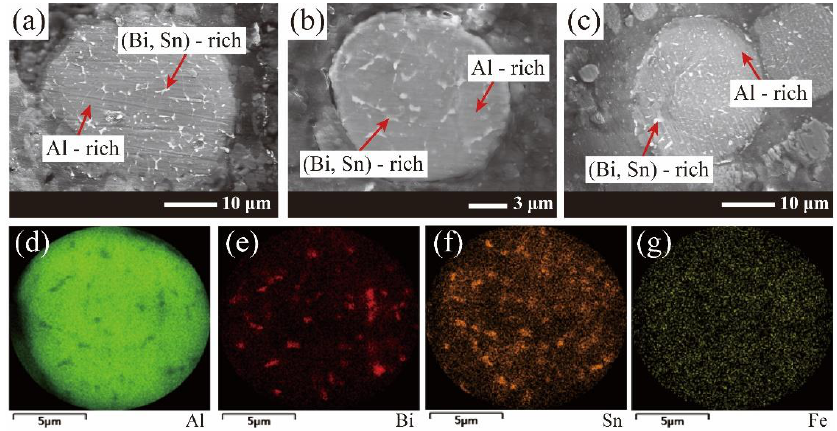
Figure 4. ( a – c ) SEM images of the cross-section morphology of Al-10Bi-7Sn-xFe (x = 0, 0.5, 1.5, 3) (wt.%) powders: ( a ) Al-10Bi-7Sn-0.5Fe (wt.%), ( b ) Al-10Bi-7Sn-1.5Fe (wt.%), ( c ) Al-10Bi-7Sn-3Fe (wt.%); ( d – g ) the EDS elemental mapping of Al-10Bi-7Sn-1.5Fe (wt.%) for ( d ) Al, ( e ) Bi, ( f ) Sn, ( g ) Fe.